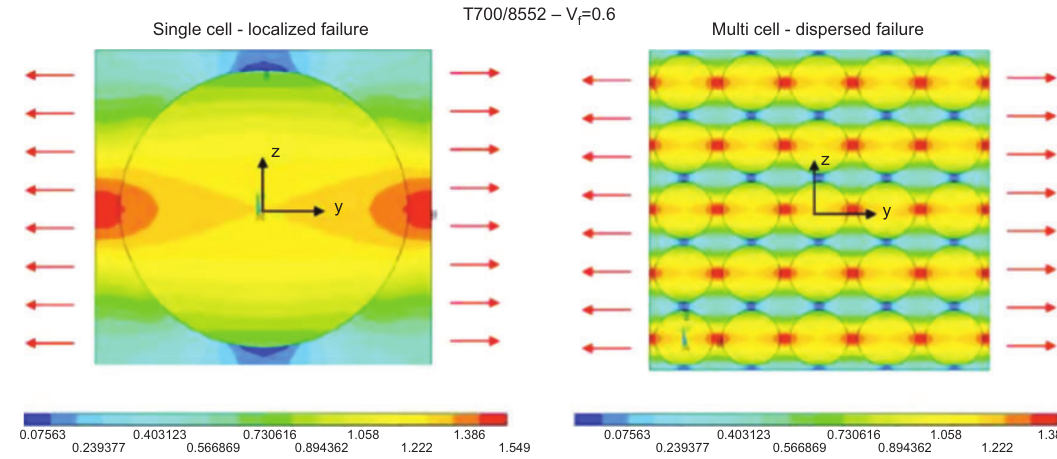
Figure 6 Unit cell approach (adapted from Huang et al. [12] ).